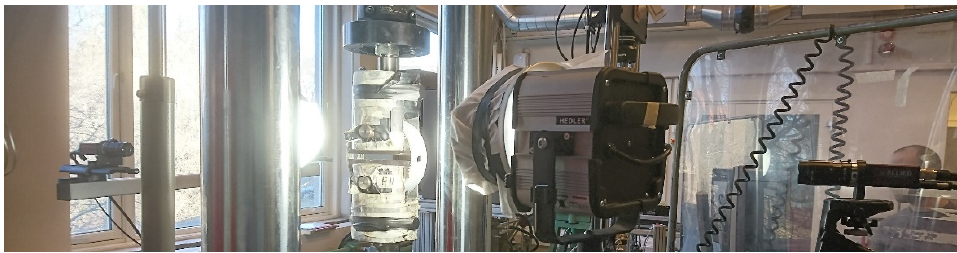
Figure 3. Cameras and test rig with specimen installed. High intensity light was used to accommodate the short shutter speed.